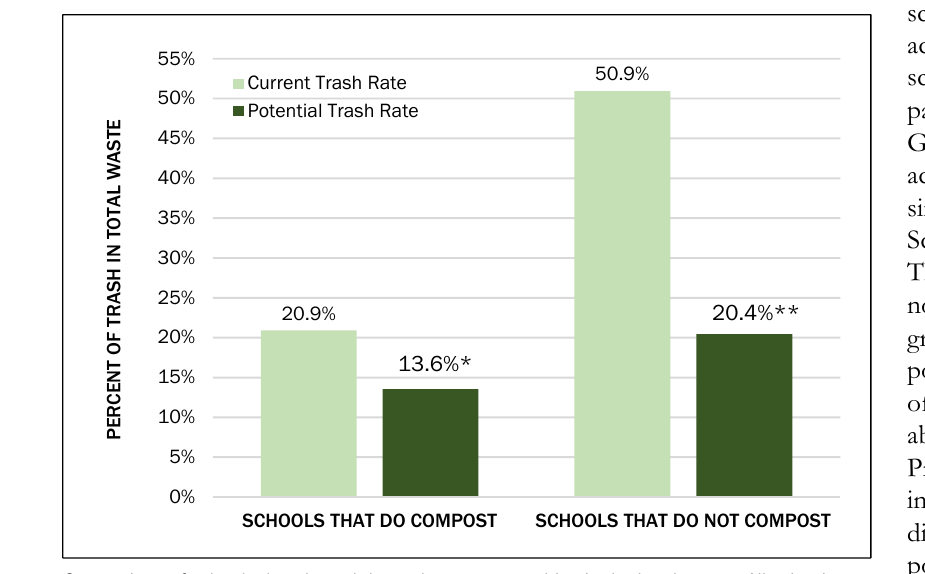
Figure 3. Difference in Pre- and Post-sort Trash Rates Based on Presence of Compost Bins